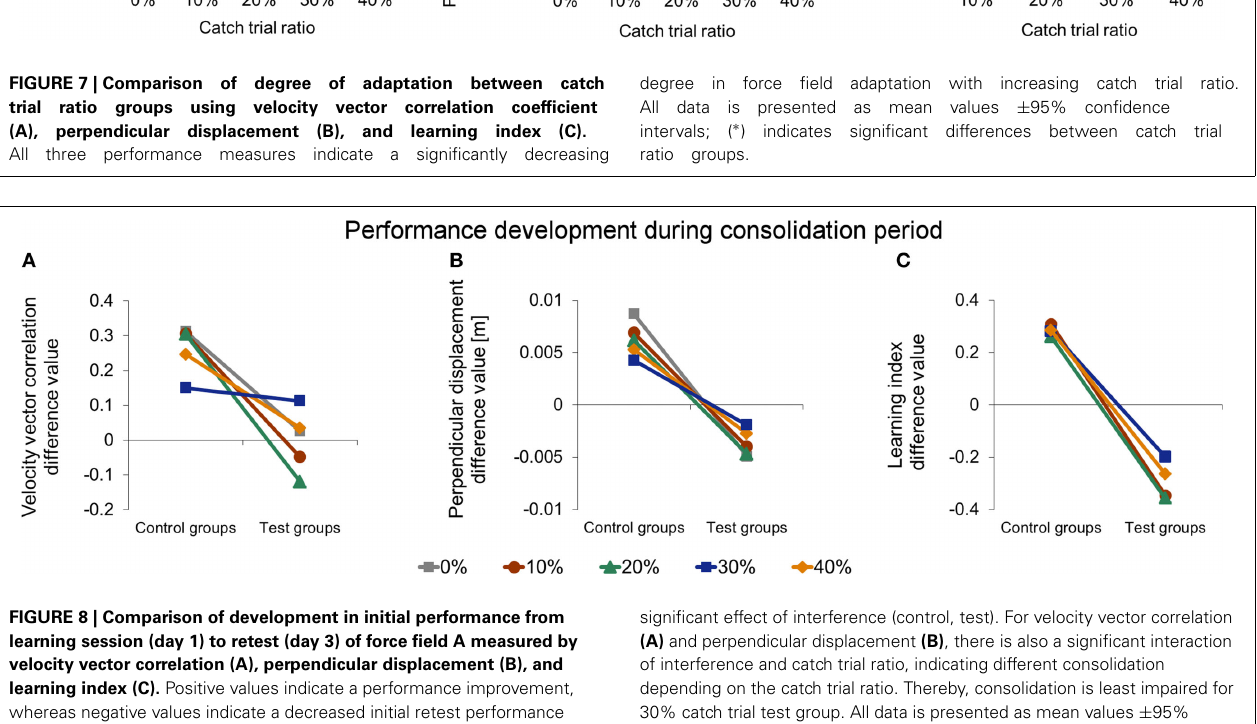
significant effect of interference (control, test). For velocity vector correlation (A) and perpendicular displacement (B) , there is also a significant interaction of interference and catch trial ratio, indicating different consolidation depending on the catch trial ratio. Thereby, consolidation is least impaired for 30% catch trial test group. All data is presented as mean values ± 95% confidence intervals; ( ∗ ) indicates significant differences between catch trial ratio